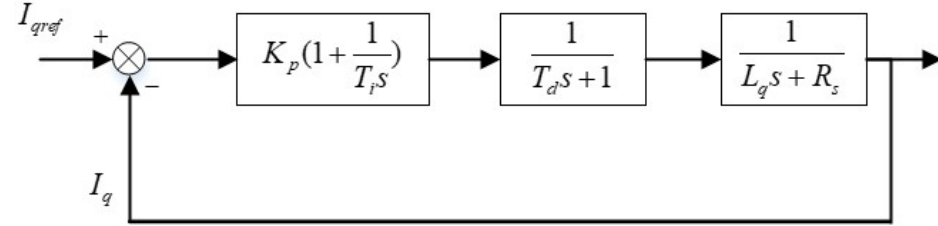
Figure 5. Double closed-loop diagram of force control of the pump control system.